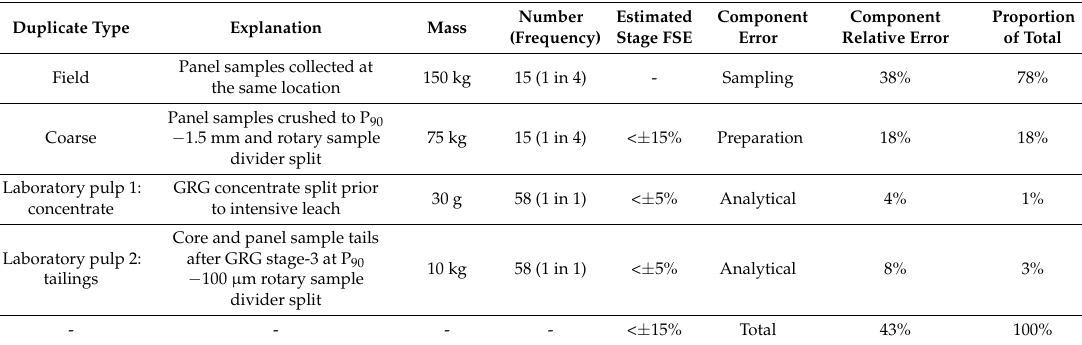
Table 22. Evaluation of errors across the underground-panel metallurgical-sample testwork programme based on duplicate samples. All FSE values reported at 90% reliability. Component relative error calculated via method presented in [14].